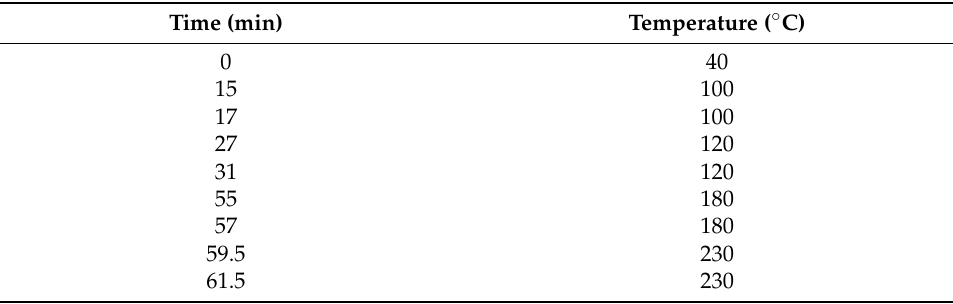
Table 4. The chromatographic conditions of